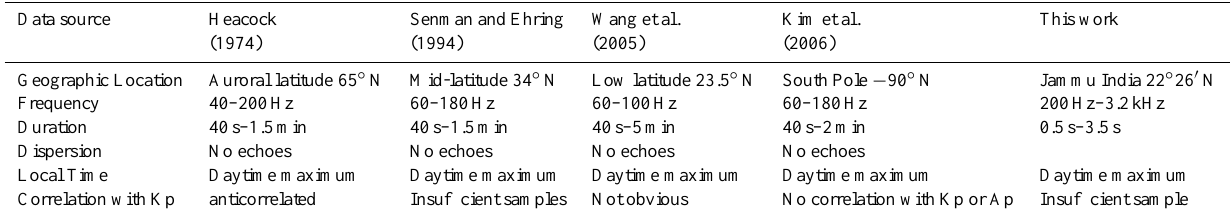
Table 2. Comparisons of ELF whistlers observations at different